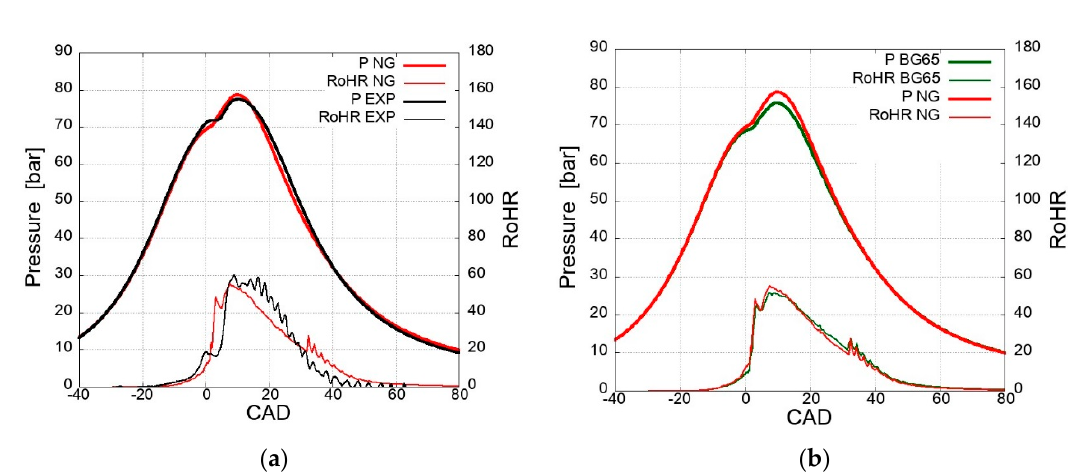
Figure 2. Comparison between the experimental and numerical results ( a ). Comparison between the Natual gas-Diesel and Biogas-diesel numerical results ( b ). Table 3. Main technical data of the reference diesel engine . Table 5. Base operating